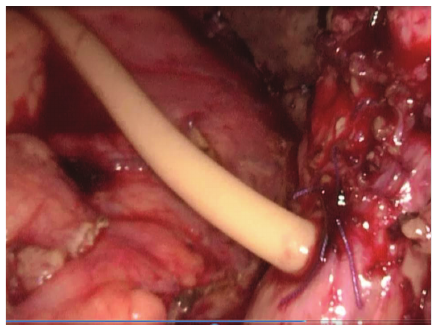
Figure 4: Gallbladder stump and choledochus were repaired over T-tube drainage with interrupted